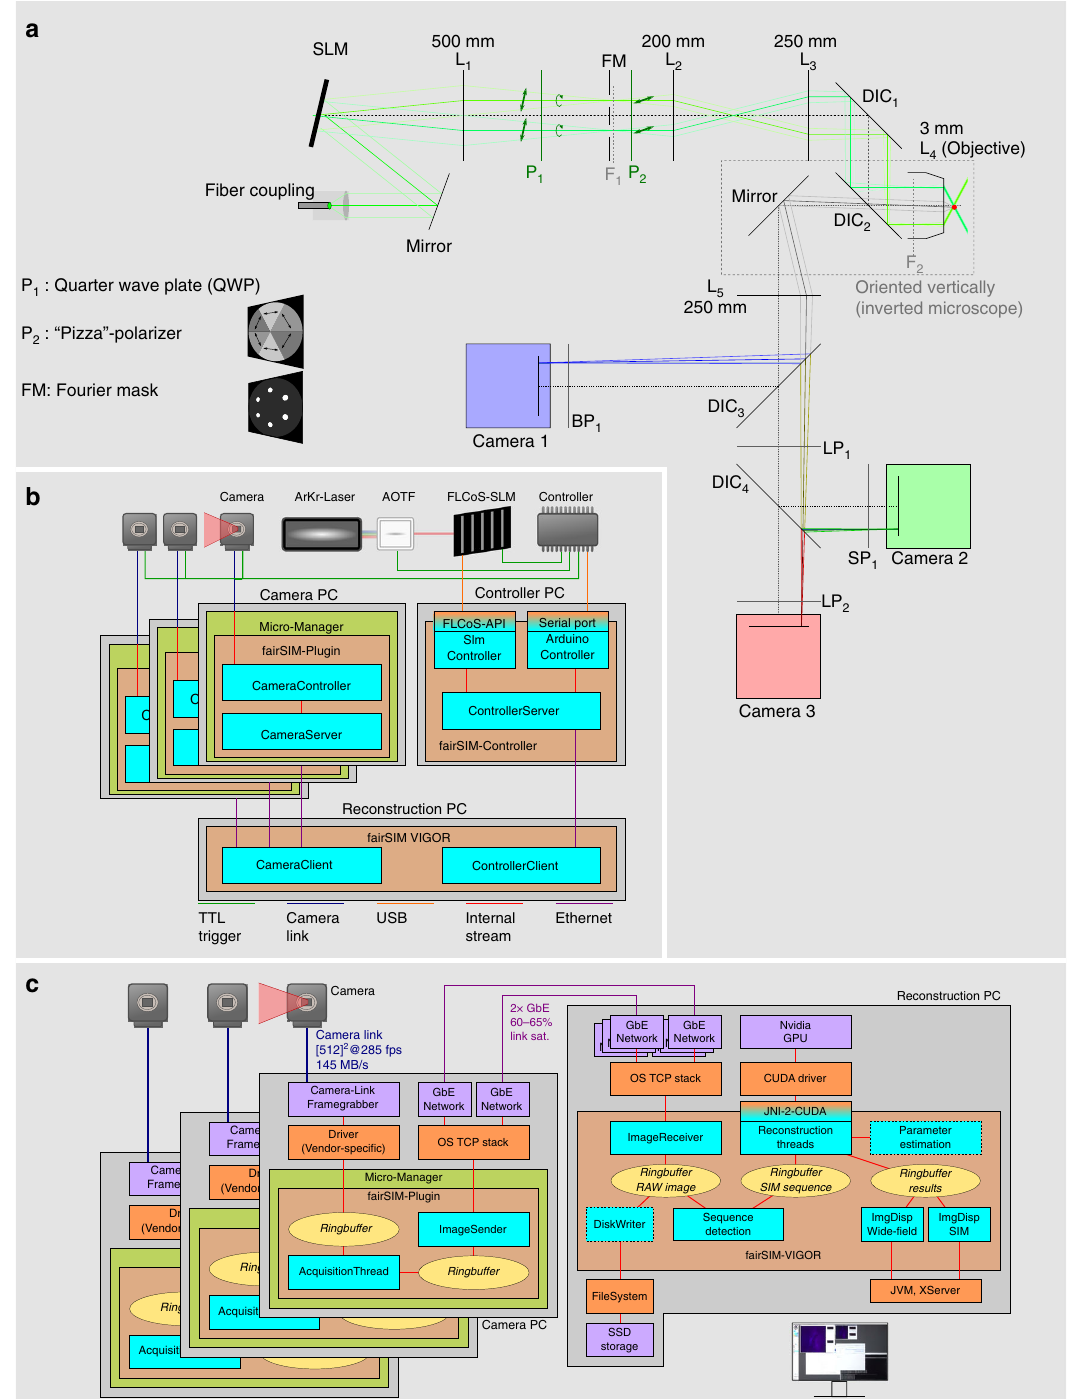
Fig. 1 Schematic overview of the setup. a Opto-mechanics are based on ref. 19 , modi fi ed for achromatic excitation and multicolor detection, for details see Supplementary Fig. 8. b The control fl ow diagram shows system components receiving both real-time timing pulses (TTL) and network-based control commands, for details see Supplementary Fig. 4. c The data fl ow diagram details how raw data acquired by the cameras travels through the on-the- fl y reconstruction pipeline, being cached in ring-buffers for robustness and optionally saved for later, of fl ine analysis. See Supplementary Fig. 3 for more